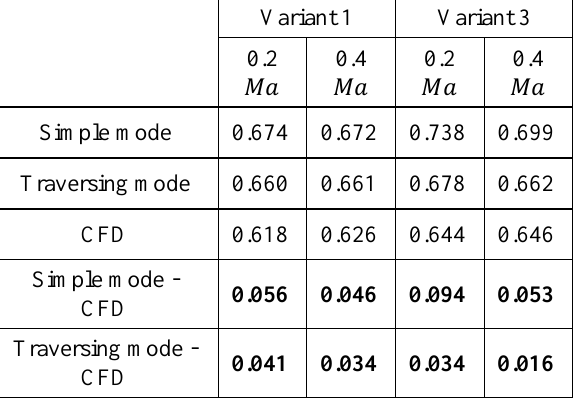
Table 6. Comparison of pressure recovery coefficient